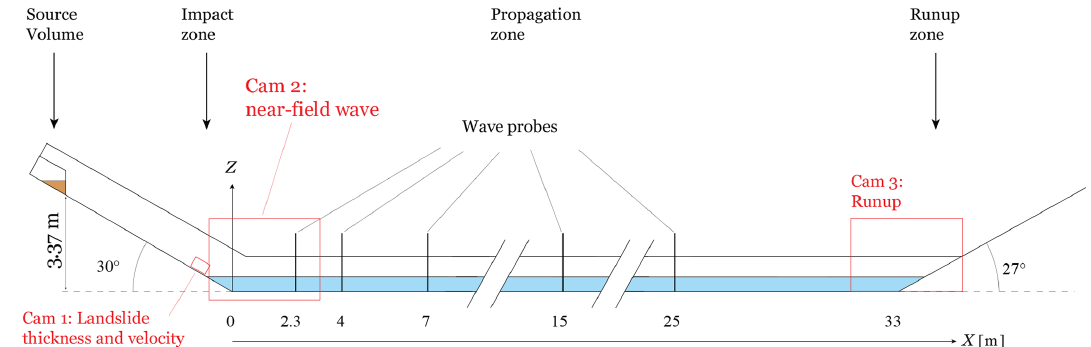
Figure 1. Sketch of the flume used in the physical model and implemented in the numerical model (modified from Miller et al., 2017).